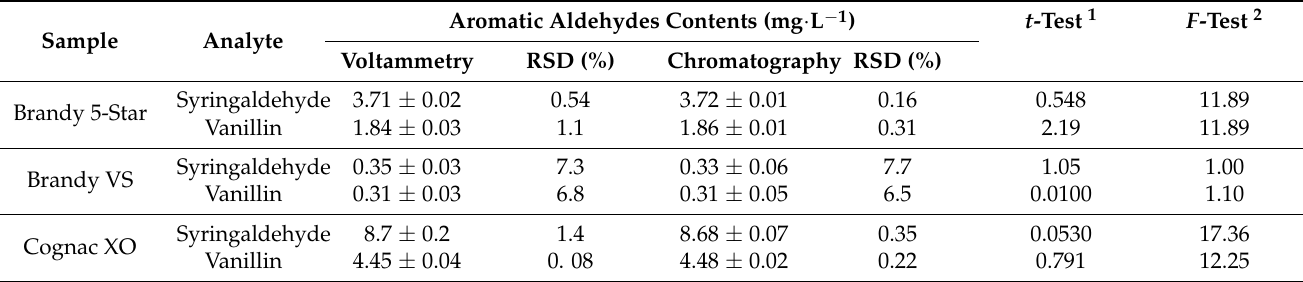
Table 8. Quantification of syringaldehyde and vanillin in brandy and cognac samples ( p =